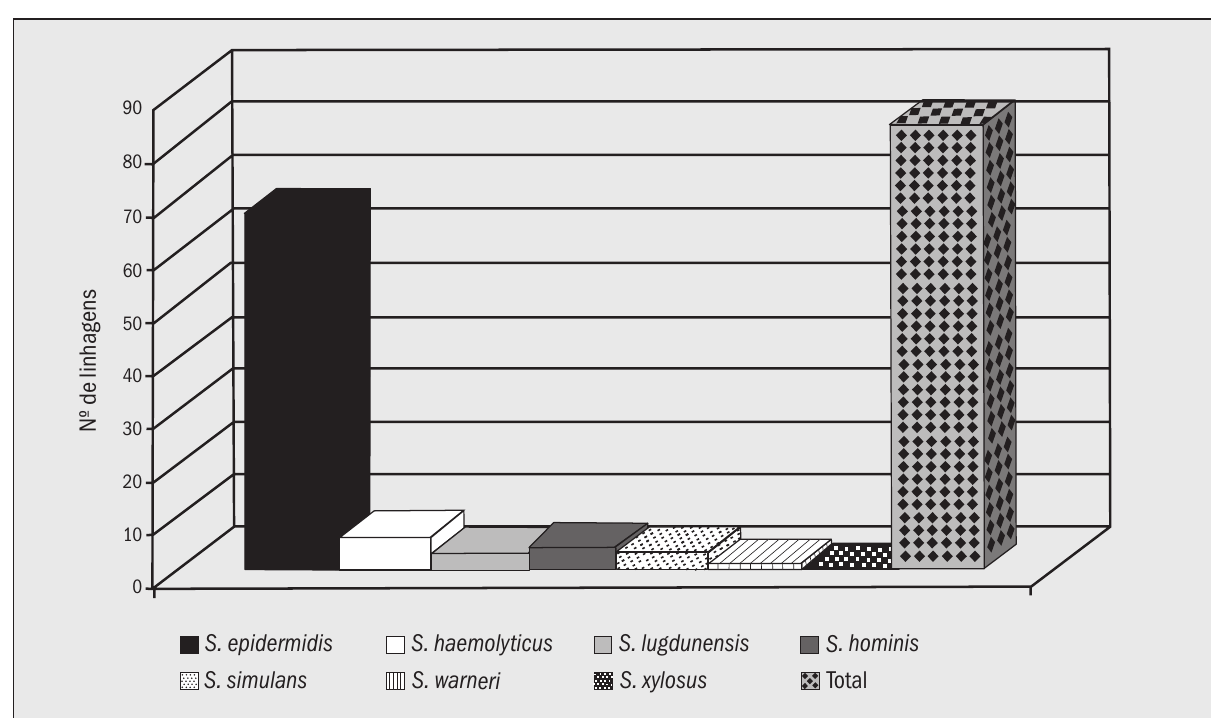
Figura 2 – Freqüência de linhagens de ECN produtoras de b